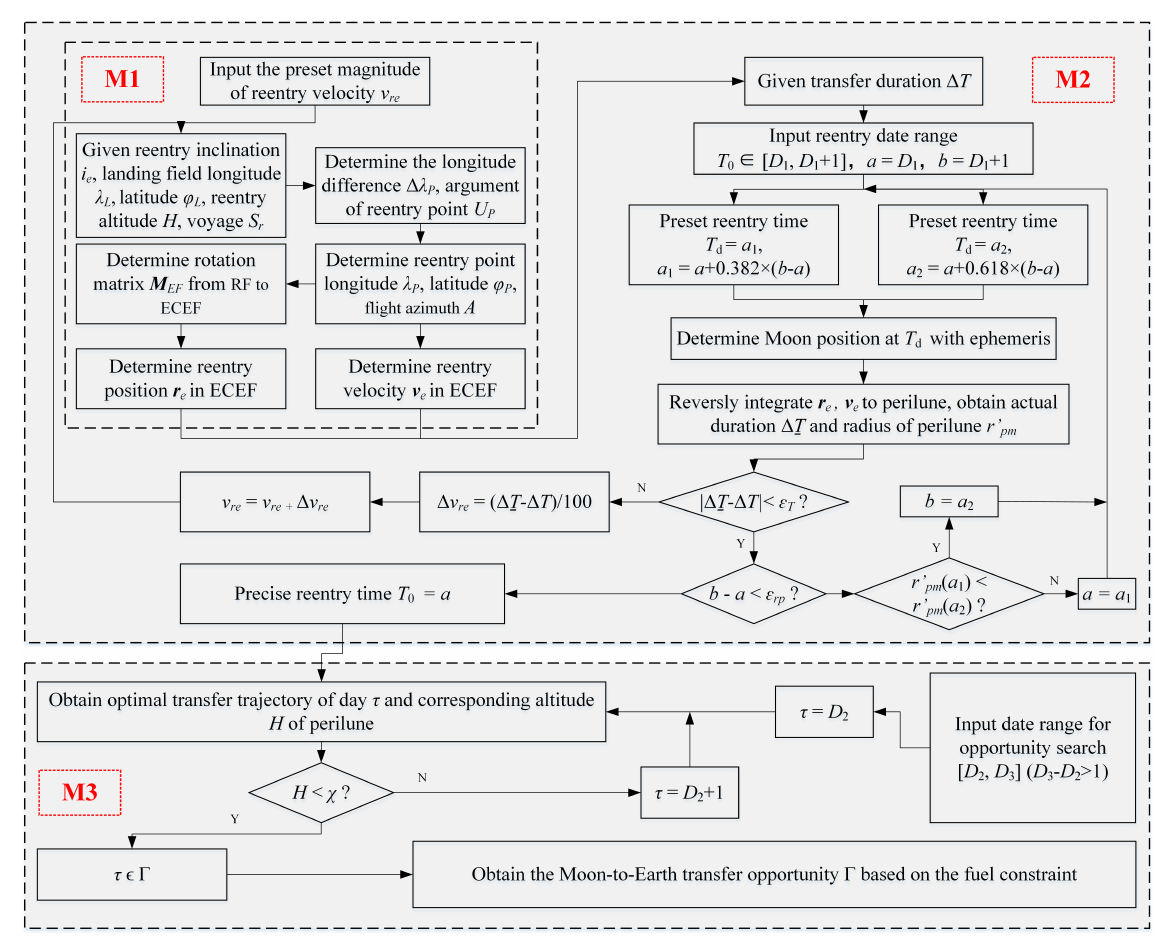
Figure 2. Flowchart for feasible transfer trajectory and opportunity determination. M1 shows the procedures for re-entry state determination; M2 shows the steps for optimal Moon-to-Earth trajectory design; M3 reveals the transfer opportunity screening